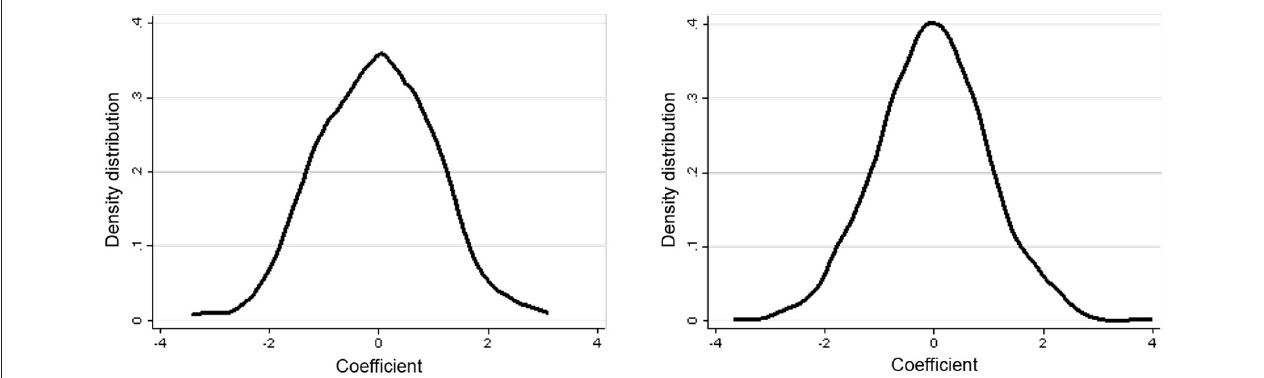
FIGURE 3 | Placebo test results using 500 and 1,000 random counterfactual explanatory variables. All regressions include all control variables and provincial fixed effects.